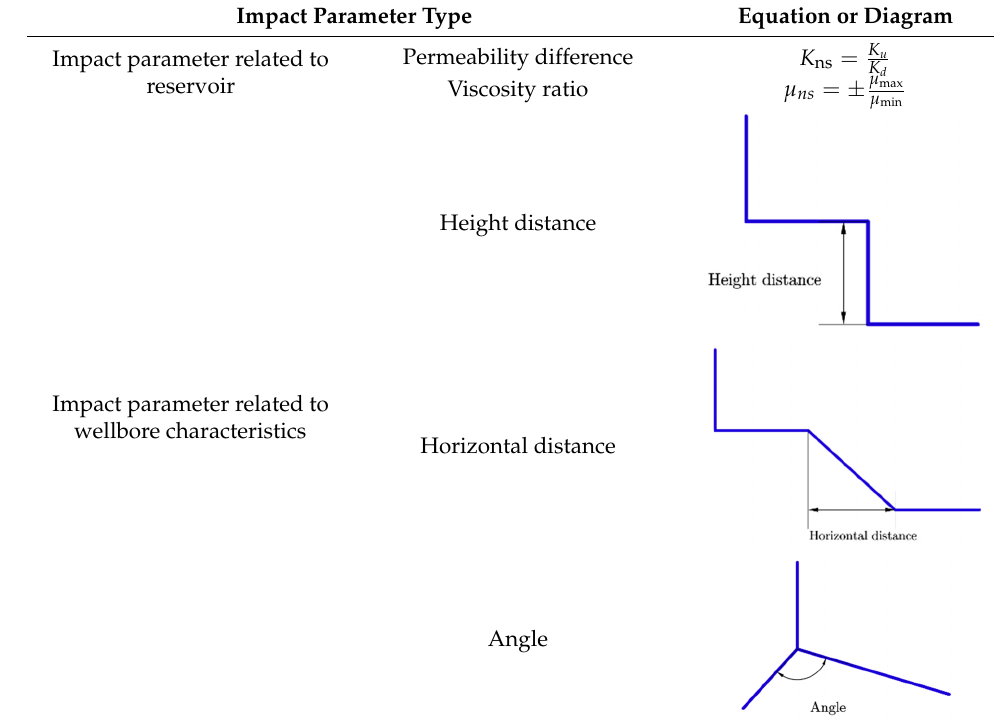
Table 7. The list of all impact parameters.